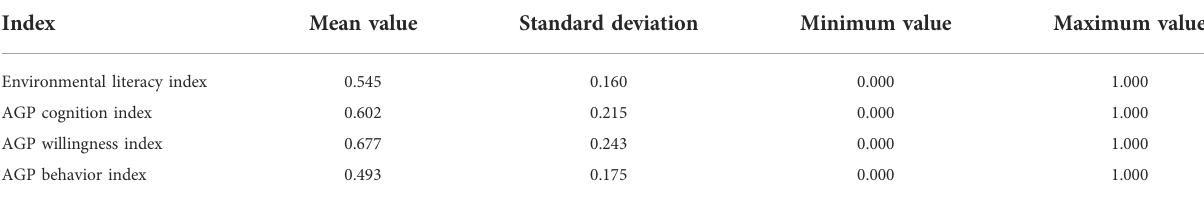
TABLE 4 Measurement results of latent